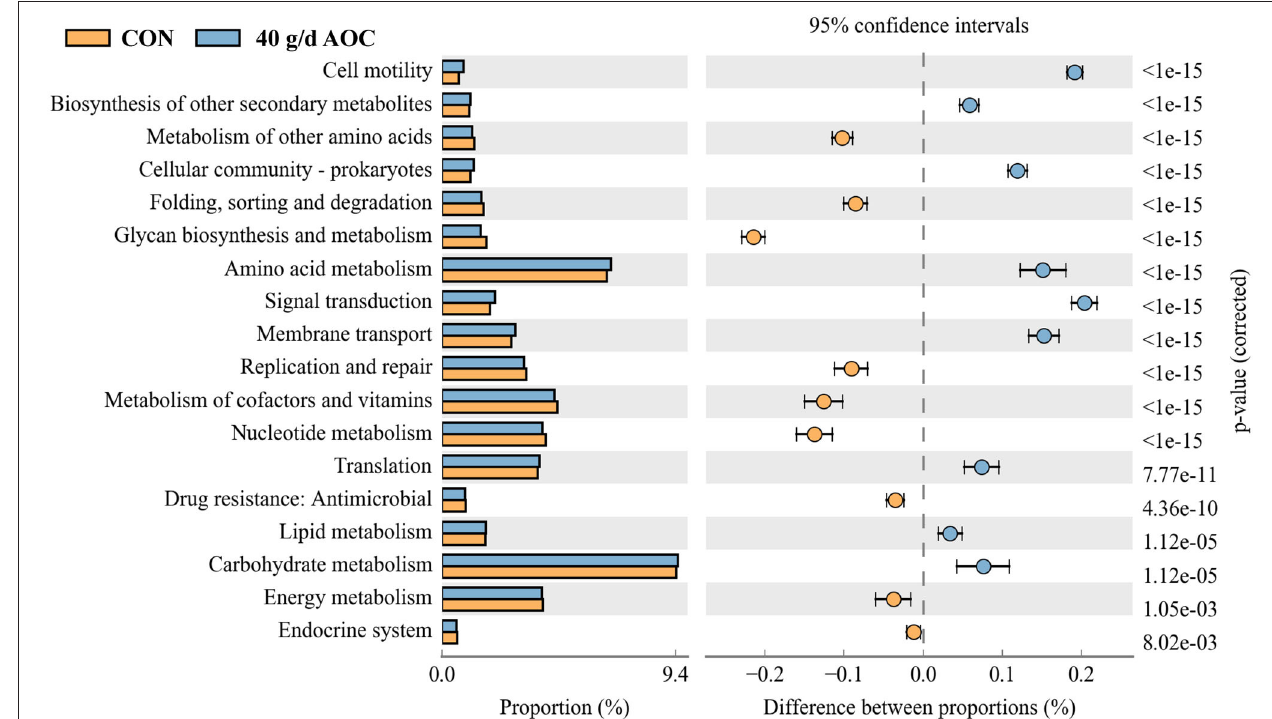
FIGURE 4 | Predict of bacterial function in rumen by KEGG between CON and 40 g/d AOC supplementation using PICRUSt 2 method. Orange represent the CON, blue represent 40 g/d AOC